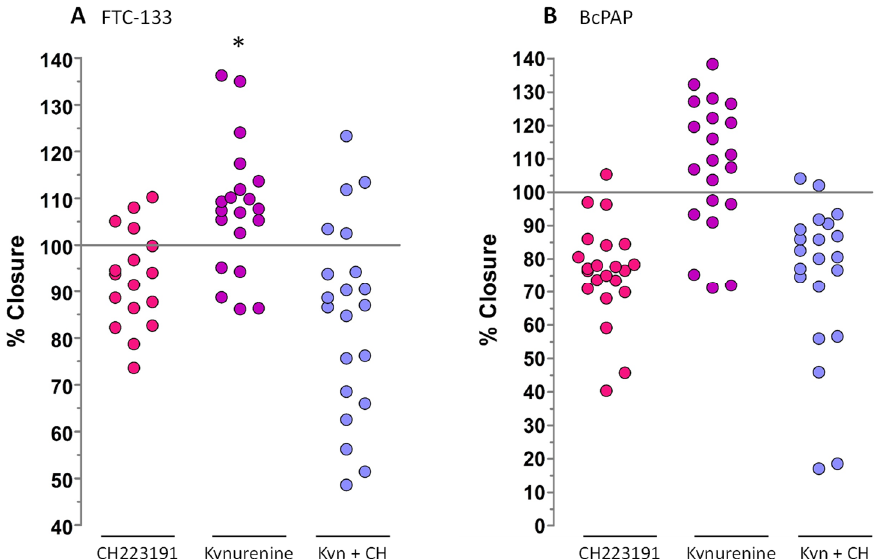
Figure 11. Wound healing assay. FTC-133 and BcPap cells were seeded in 96 well plates and, at confluence, stoppers were removed, and cells treated with kynurenine (100 µM) and/or CH223191 (10 µM). Images were acquired and the free cells area was measured with ImageJ software. The data are presented as means of percentage of wound closure obtained normalizing the free cells area of each sample with the free cells area of untreated cells. Data of three independent experiments, in which each samples was repeated six times, were collected. Kyn: kynurenine treated cells; CH: CH223191 treated cells. ( A ) FTC-133 cell; ( B ) BcPap cell. p values were calculated applying the one sample Student’s t test. *, p < 0.05.